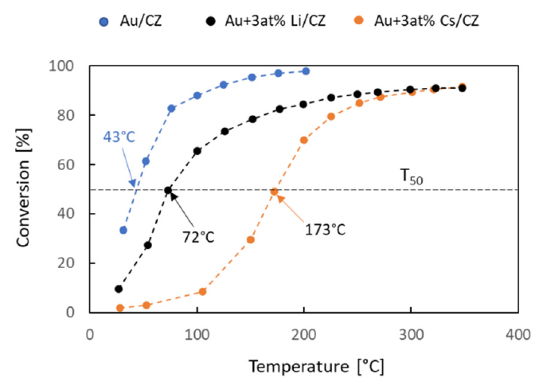
Figure 10. Results of CO oxidation tests in the model stream of Au/CZ, Au + 3 at% Li/CZ and Au3 at% Cs/CZ.